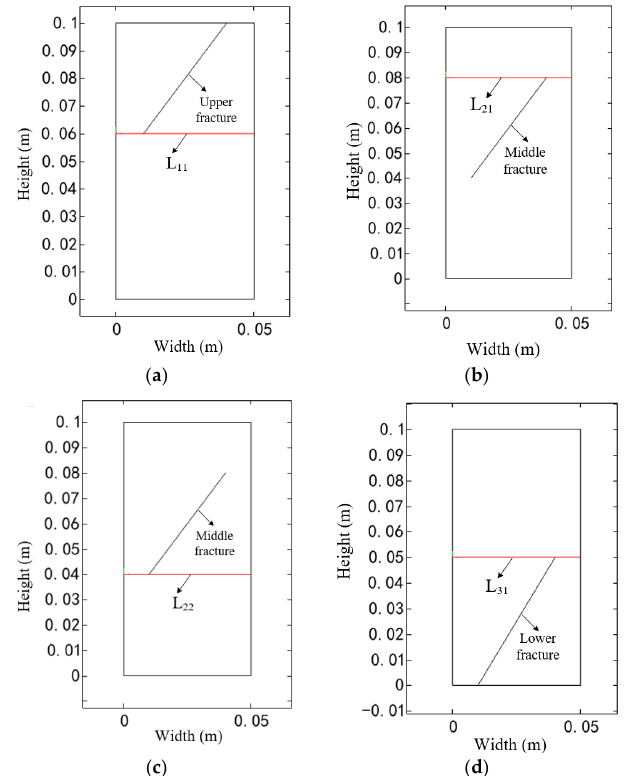
Figure 19. The locations of the transversal line. ( a ) Transversal line L 11 ; ( b ) transversal line L 21 ; ( c ) transversal line L 22 ; ( d ) transversal line L 31 .